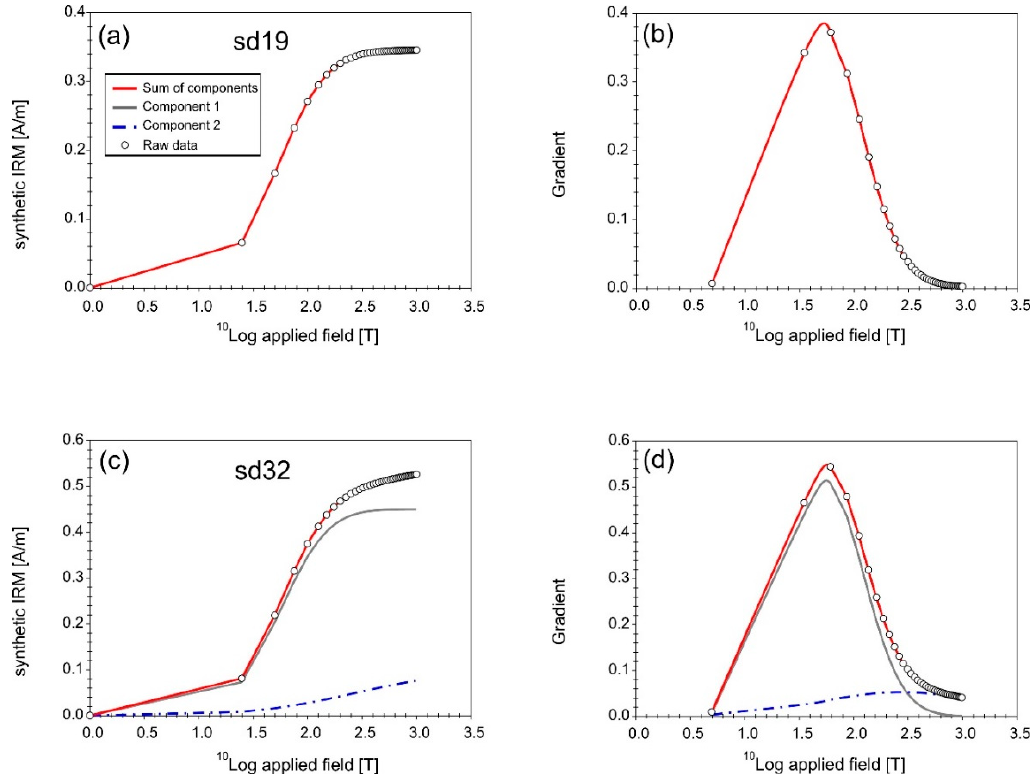
Figure 4. Thermomagnetic curves of magnetic susceptibility— κ (T) for the street dust samples ( a , c ). Thermal demagnetization of saturation remanent magnetization—SIRM(T) curves for the street dust samples ( b , d ). Description of the κ (T) and SIRM (T) curves is the same as in Figure 2.